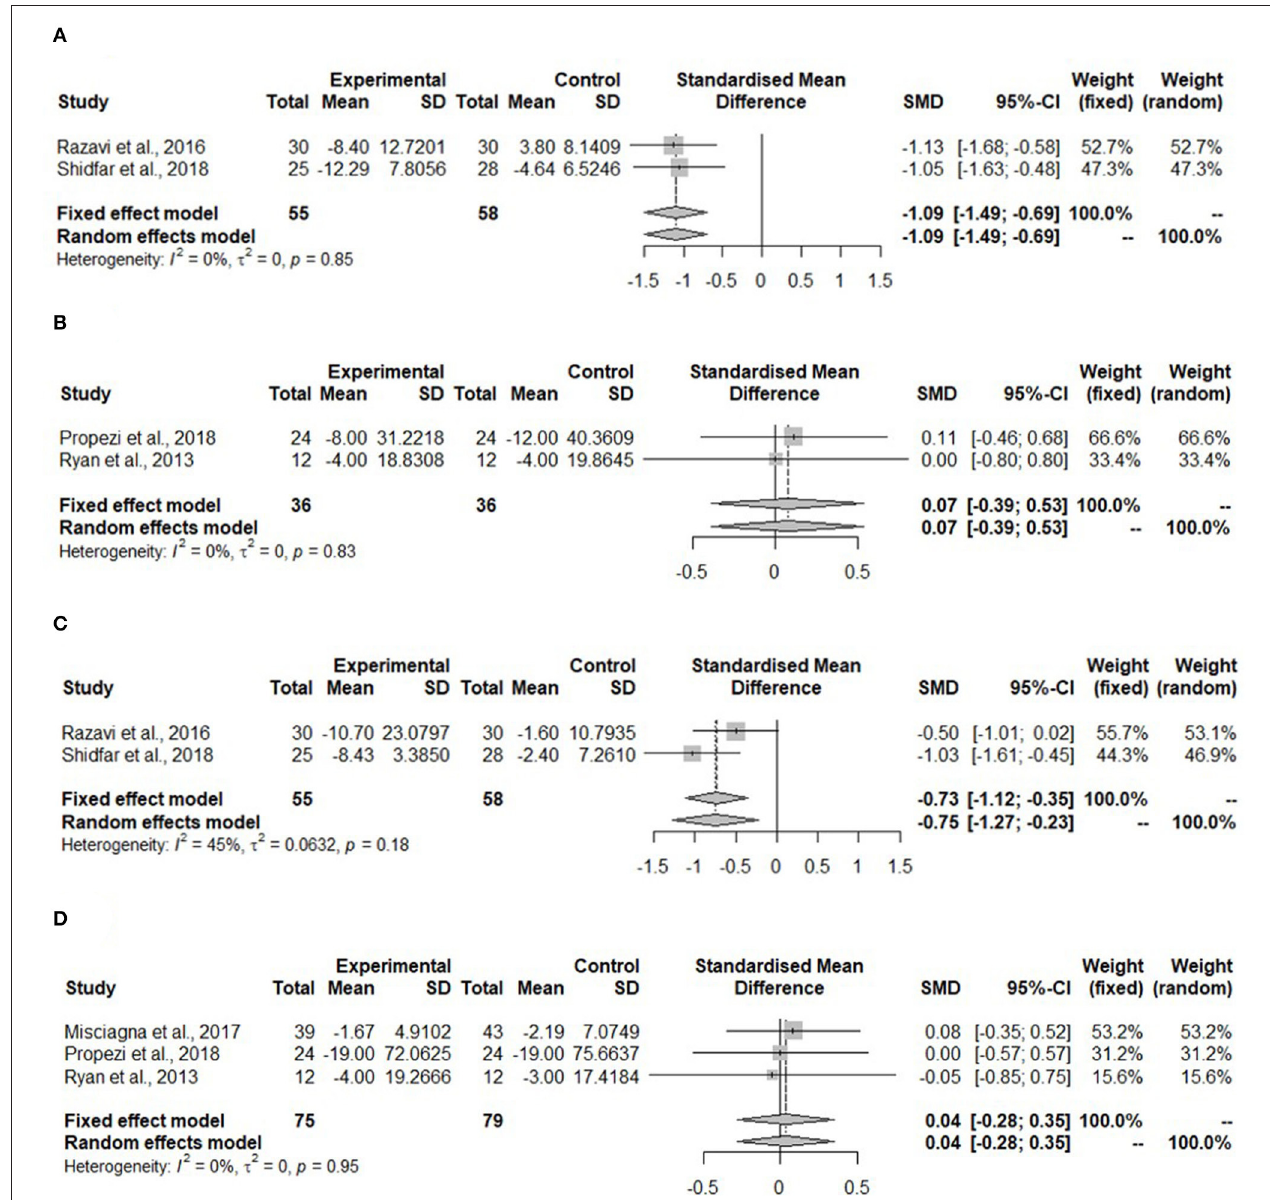
FIGURE 3 | Forest plots of (A) alanine aminotransferase (ALT) in hypo-caloric group; (B) ALT in isocaloric group; (C) aspartate aminotransferase (AST) in hypocaloric group; (D) gamma-glutamyl transferase ( γ GT) in isocaloric group; SD, standard deviation; SMD, standardized mean difference.